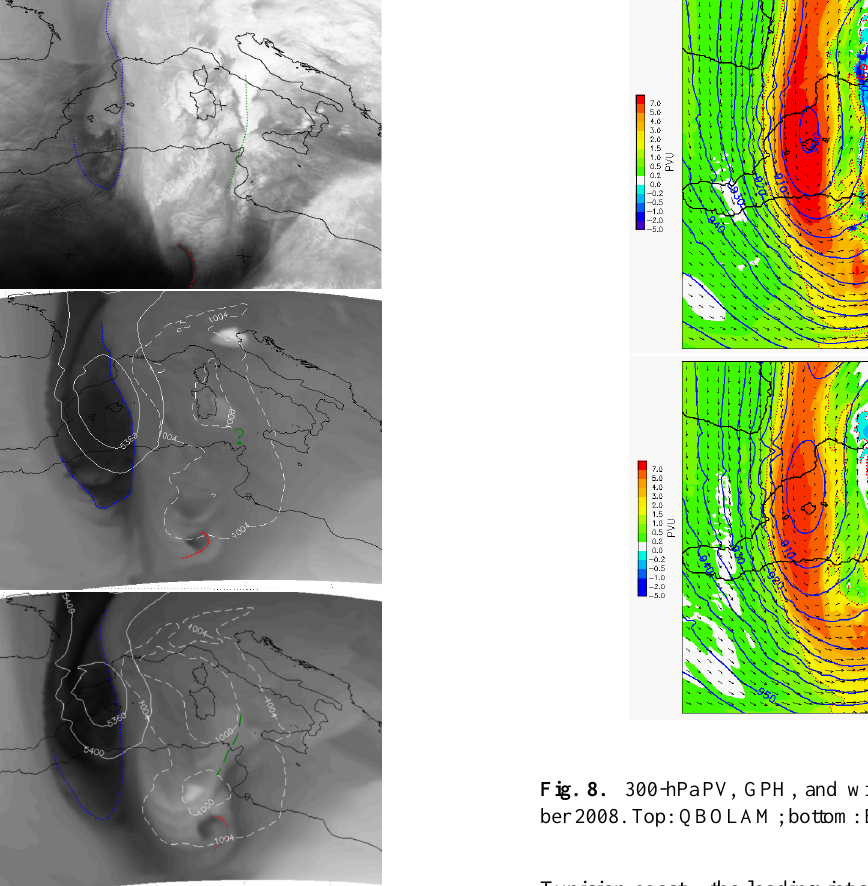
Fig. 7. PWV analysis at 0000 UTC 11 December 2008. Top: MSG 6.2 WV image; middle: QBOLAM PWV image; bottom: BOLAM 2007 PWV image. Selected GPH 500 hPa isolines (white solid lines) and surface isobars (white dashed lines) are included, for reference, on forecast plots.